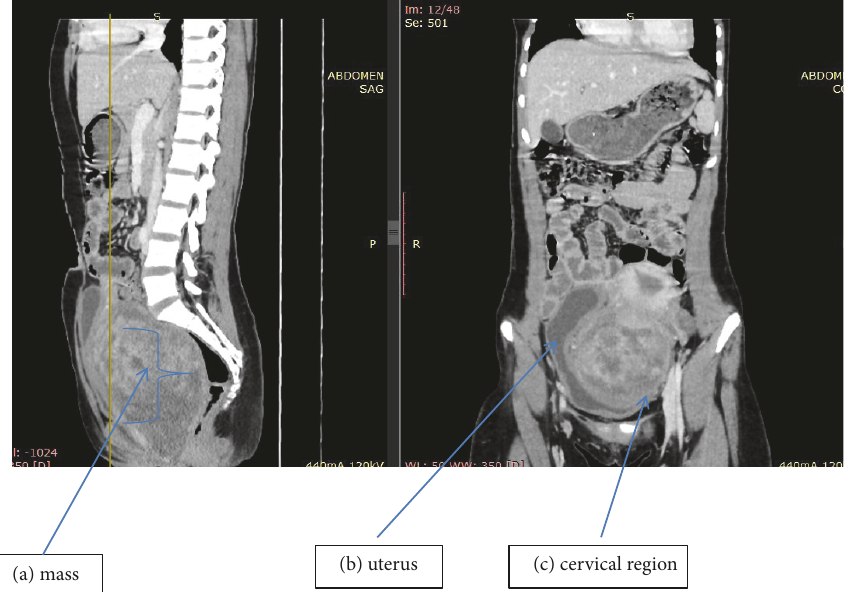
Figure 1: Computed Tomography (CT) scan of the abdomen and pelvis. Arrow heads show hypodense contrast enhancing mass (a) seen on the uterus (b) arising from the cervical region (c).